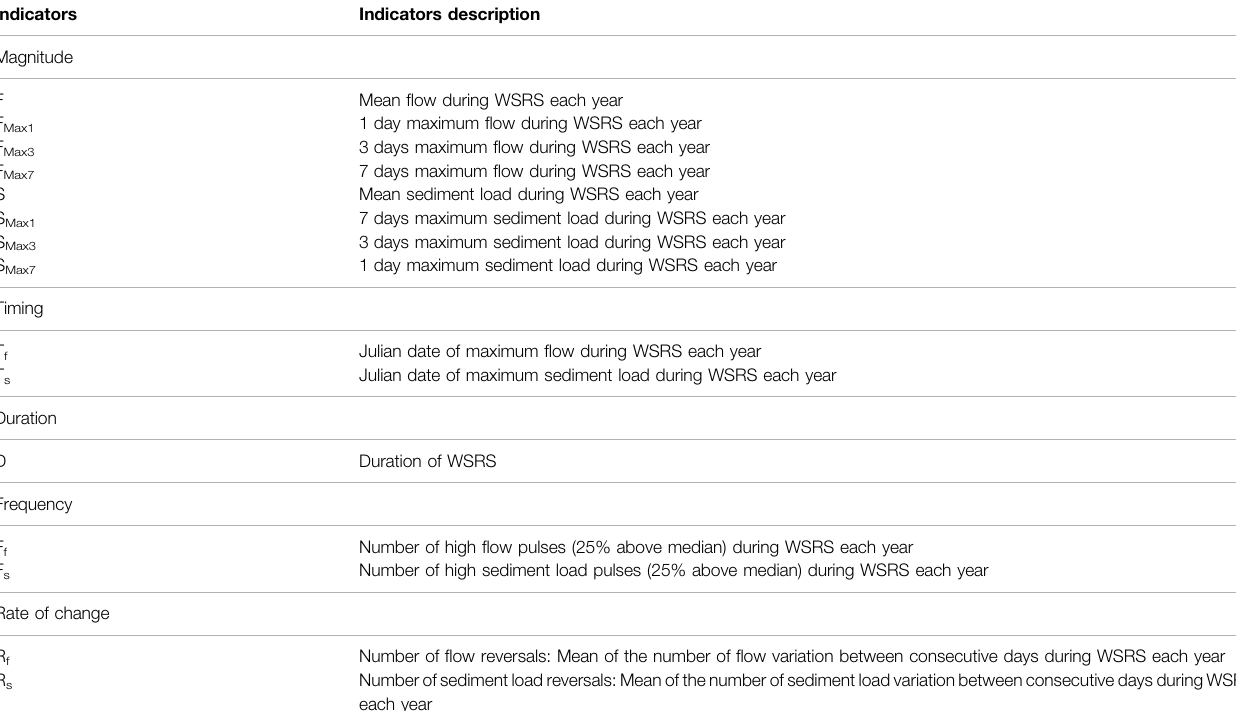
TABLE 3 | Flow-sediment regime indicators used in this study.